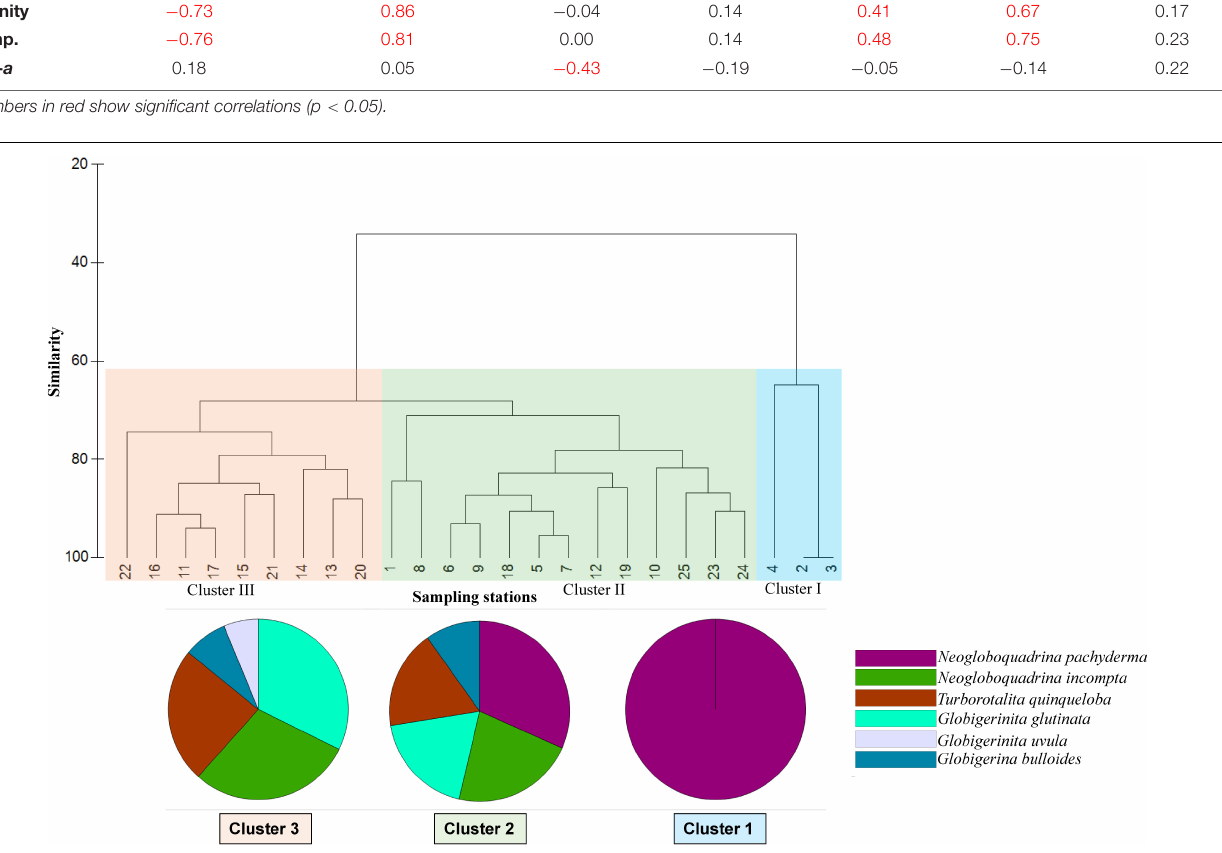
FIGURE 7 | Hierarchical cluster analysis of stations based on foraminiferal assemblages (Bray Curtis similarity). The pie charts show the contribution of different species to different clusters (by SIMPER